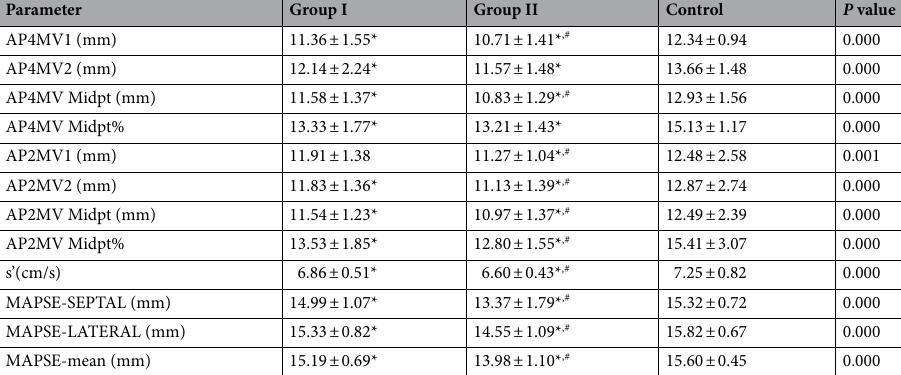
Table 4. MAPSE, s’ and TMAD parameters. Data are presented as mean ± standard deviation. TMAD, tissue mitral annular displacement; AP4MV1, displacement of the septal annulus toward the apex; AP4MV2, displacement of the lateral annulus toward the apex; AP4MV Midpt, displacement of a midpoint in a four-chamber view toward the apex; AP4MV Midpt%, proportional displacement of a midpoint in a four- chamber view toward the apex (AP4MV Midpt/left ventricular end-diastolic internal diameter); AP2MV1, displacement of the anterior annulus toward the apex; AP2MV2, displacement of the inferior annulus toward the apex; AP2MV Midpt, displacement of a midpoint in a two-chamber view toward the apex; AP2MV Midpt%, proportional displacement of a midpoint in a two-chamber view toward the apex (AP2MV Midpt/ left ventricular end-diastolic internal diameter). MAPSE, Mitral Annular Plane Systolic Excursion. *Compared with control group, P < 0.05. # Compared with group I, P < 0.05.